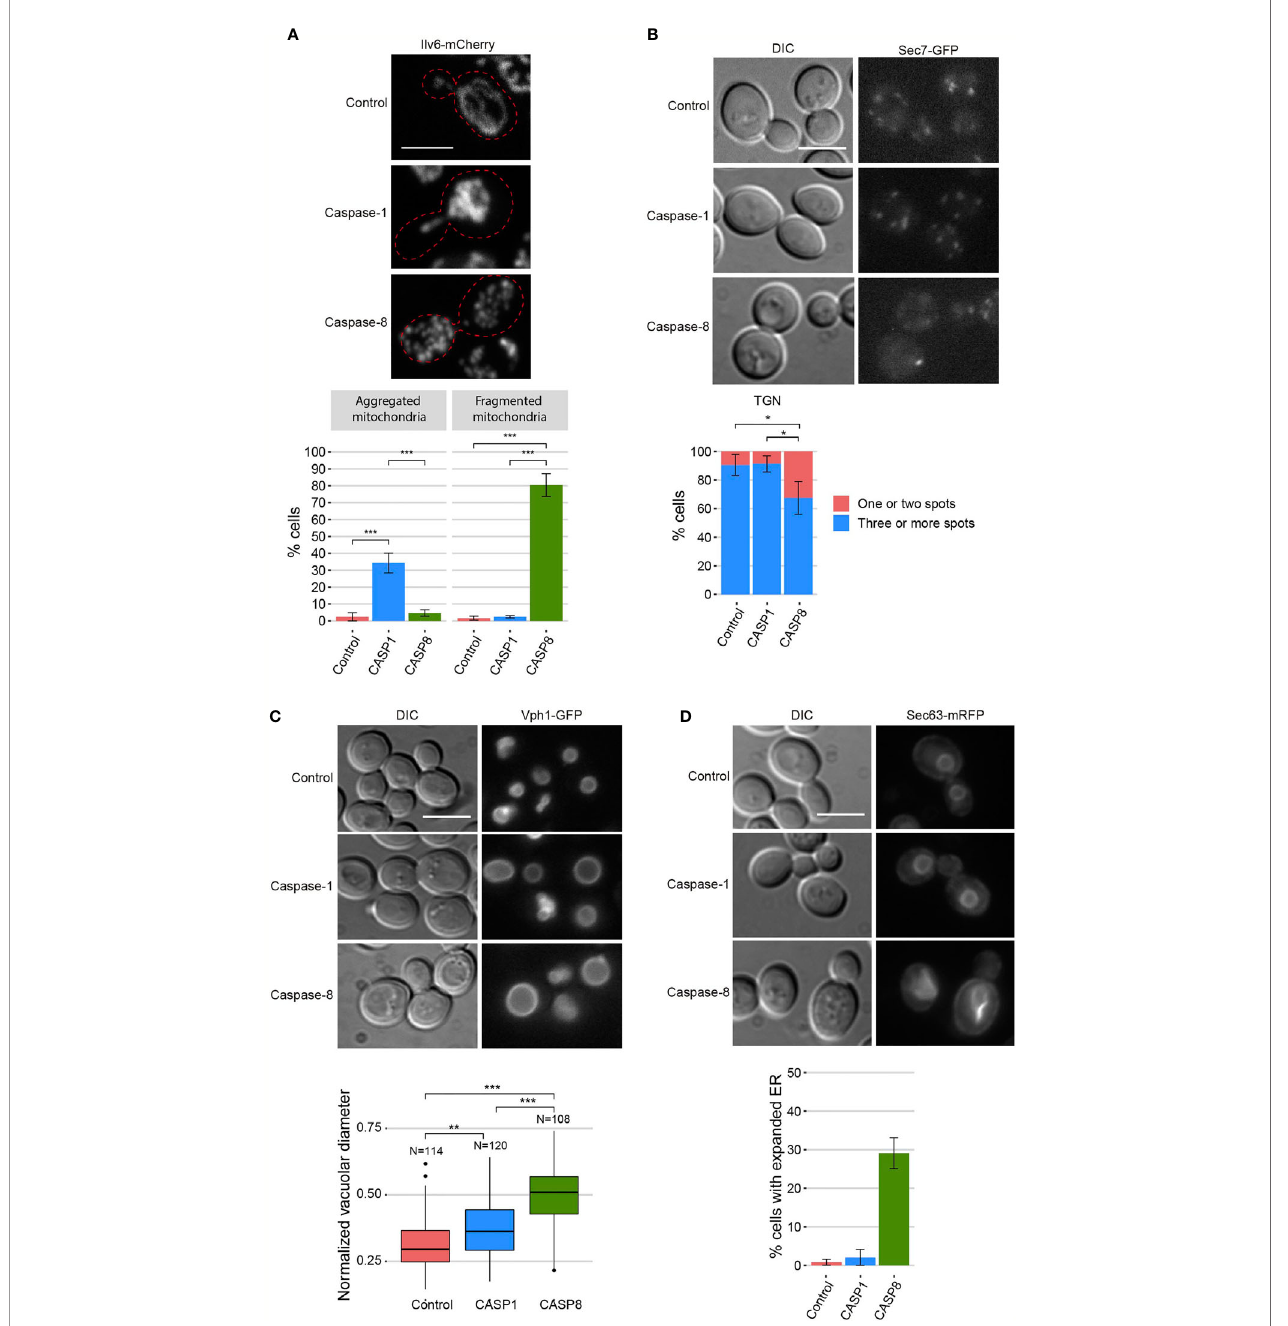
FIGURE 4 | Caspase-1 and caspase-8 overexpression alters subcellular organelles. (A) Confocal fl uorescent microscopy and quanti fi cation (n > 100) of the mitochondrial phenotype of BY4741 trp1 D strain bearing the mitochondrial marker pYEp-lac112-Ilv6-Cherry and the same plasmids as in Figure 1B . (B) Fluorescent and bright fi eld differential interferential contrast (DIC) microscopy (left panel) and quanti fi cation (n > 100) of the number of TGN spots per cell (right panel) of DLY35 strain, bearing the TGN marker Sec7-GFP, and the same plasmids as in Figure 1B . (C) Fluorescent and bright fi eld (DIC) microscopy (upper panel) and boxplot (n > 100) representing the vacuolar diameter normalized by cell diameter (lower panel) of MVY04 strain, bearing the vacuolar marker Vph1-GFP, and the same plasmids as in Figure 1B . (D) Fluorescent and bright fi eld (DIC) microscopy (upper panel) and quanti fi cation (n > 100) of the percentage of cells showing expanded ER (lower panel) of BY4741 strain bearing the ER marker pRS425-Sec63-mRFP and the same plasmids as in Figure 1B . Abnormal ER expansions were considered following previously described criteria (32). Caspase-1 and caspase-8 expression were induced in SG medium for 5 h in all cases. All scale bars indicate 5 µm. Results correspond to the mean of three biological replicates performed on different transformants. Error barsrepresent SD.Asterisks (*, **,***) indicate a p-value < 0.05 by the Tukey ’ s HSD test inpanels (A,B) and < 0.01 and0.001, respectively, by the Dunn ’ s test inpanel (C)